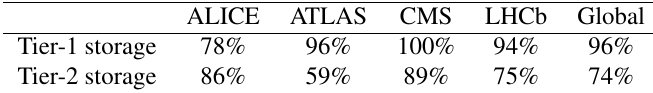
Table 1. Fraction of Tier-1 and Tier-2 storage available over